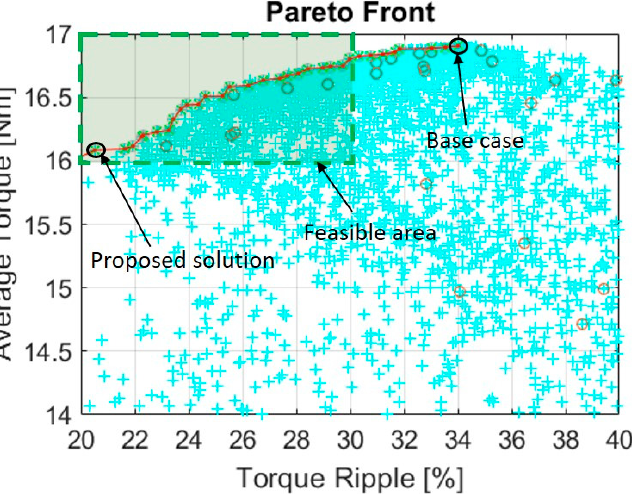
Figure 13. Pareto front, feasible area, and proposed solution for a current value of 260 A.